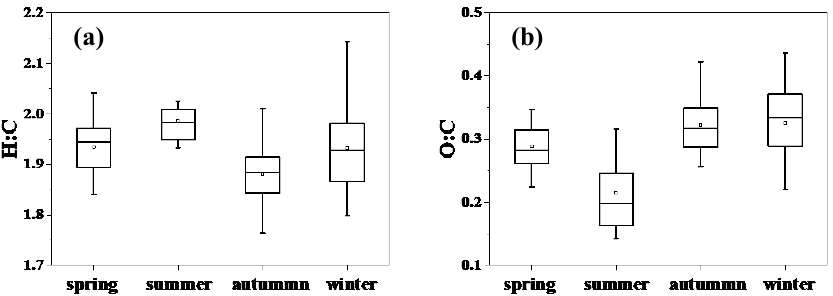
Figure 4. Seasonal variations of average ( a ) H:C and ( b ) O:C. The data points of H:C and O:C distribution in each season are displayed in the VK-OSc space in Figure 5. The slopes of the fitting lines of H:C versus O:C plotted in the VK-OSc space could indicate the aging pathways of OA [55,56]. Most of the data points of H:C and O:C were all located in the region between the lines, with a slope = 0 and a slope = − 0.5, and the slope of the linear fitting line for these data points was − 0.24, suggesting that both the replacement of the alcohol groups (–OH) and carboxylic acid functional groups (–COOH) contributed to the formation of WSOC [56]. Compared with previous studies, the distributions of H:C and O:C in the VK-OSc space for the different seasons were narrower, which indicated that the composition of WSOC was similar during the sampling periods throughout the year.